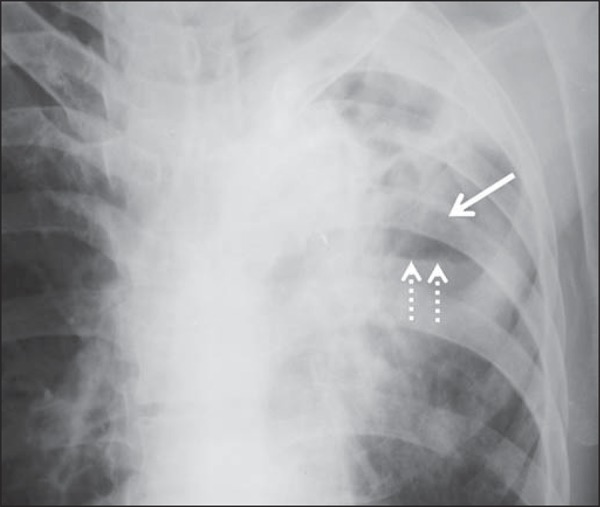
A 48-year-old man with pulmonary excavation (bold arrow) with fluid level (dashed
arrows) – an uncommon finding – in the left lung.